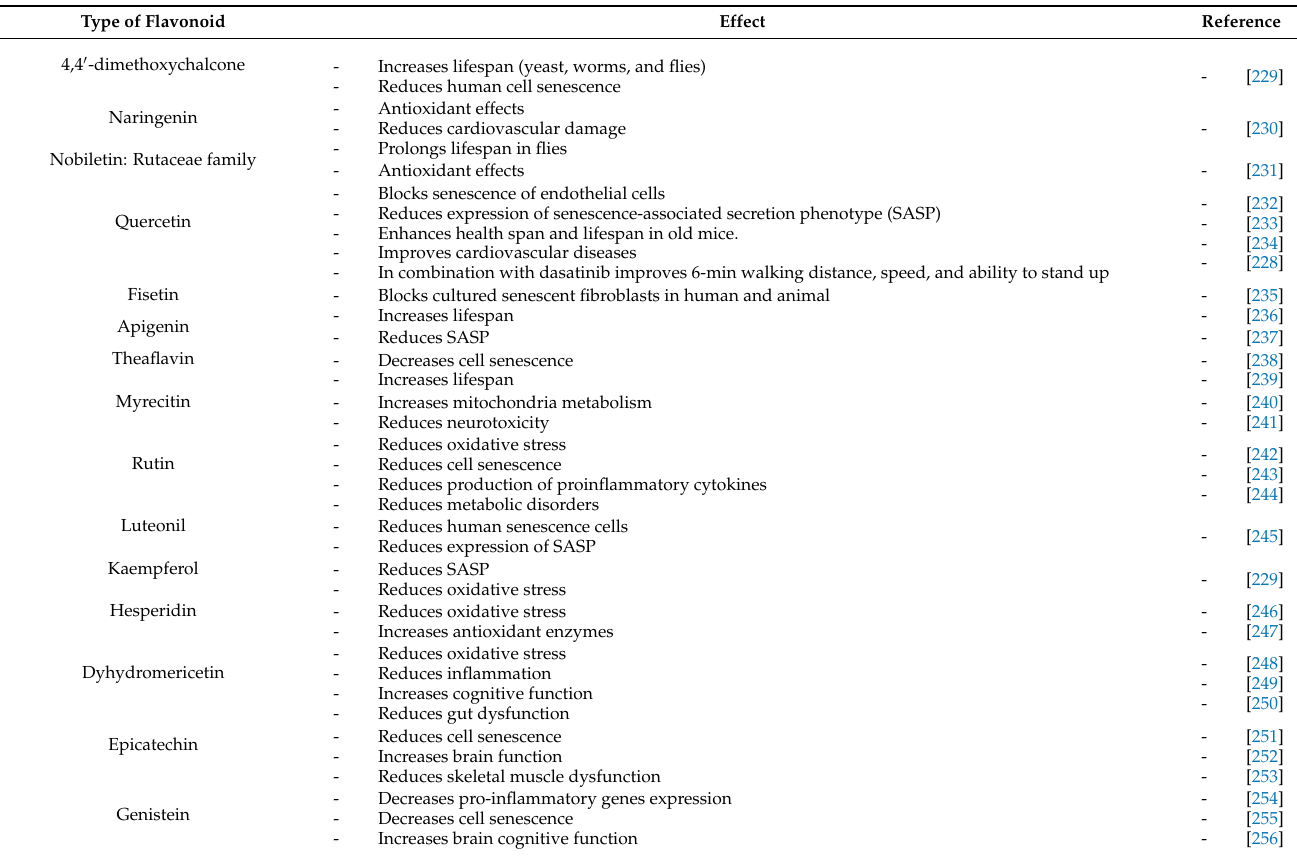
Table 3. Preclinical studies on flavonoids in